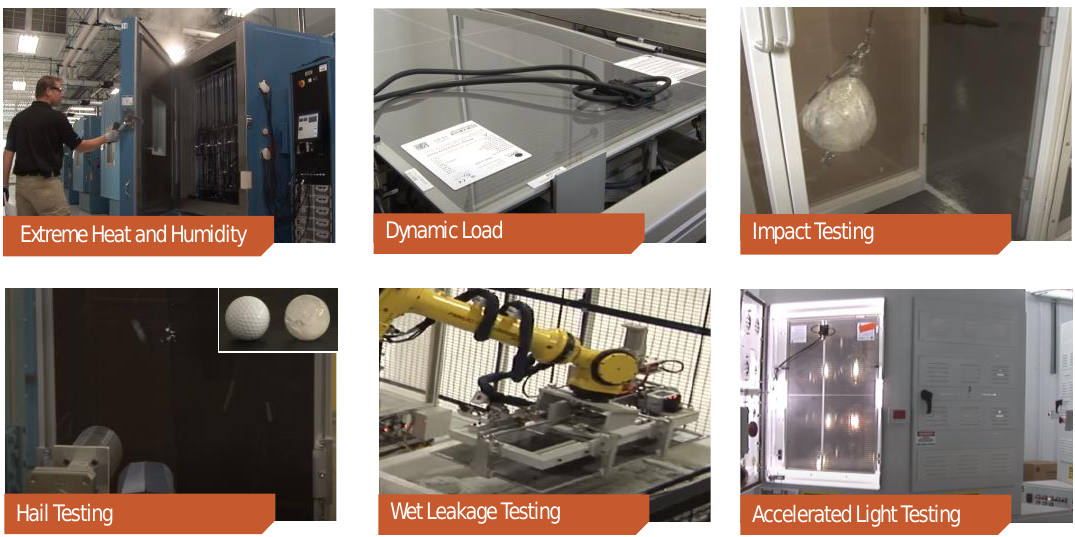
Figure 3. Examples of PV module reliability and safety tests at First Solar reliability laboratory in Perrysburg, Ohio, U.S.